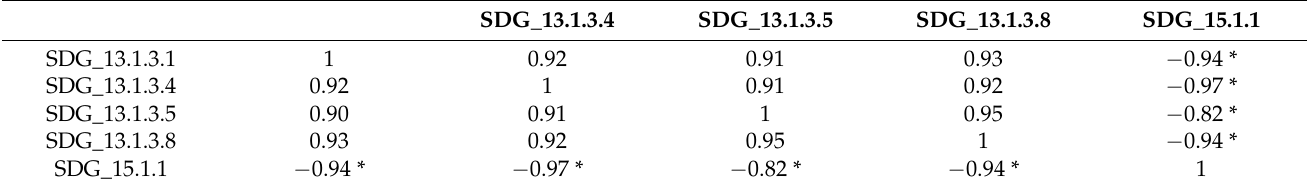
Table A7. Pairwise Pearson’s Correlation Between SDG 13 and SDG